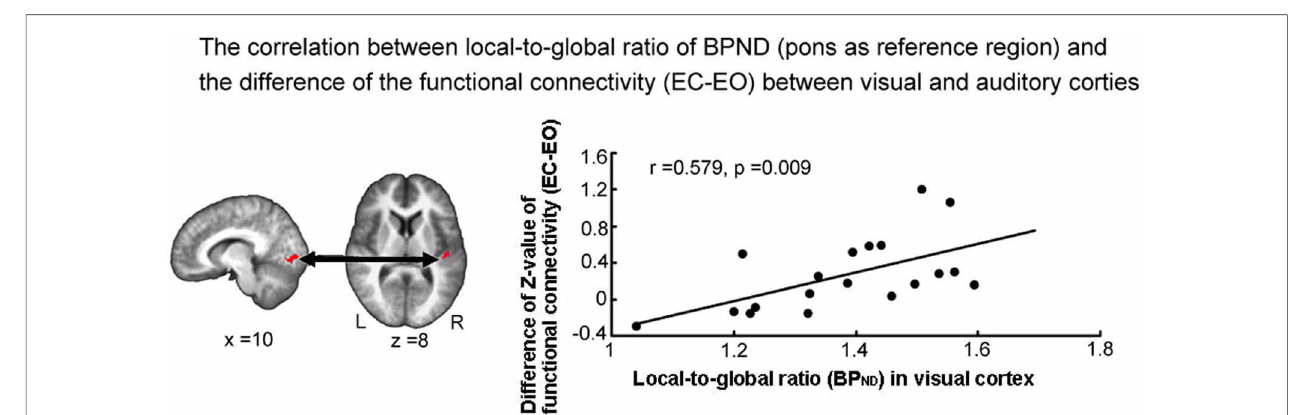
FIGURE A4 | The functional connectivity difference (EC minus EO) correlated with local-to-global ratio of BP ND (pons as reference region) of GABA A receptor in visual and auditory cortex ( r = 0 . 579, p = 0 . 009